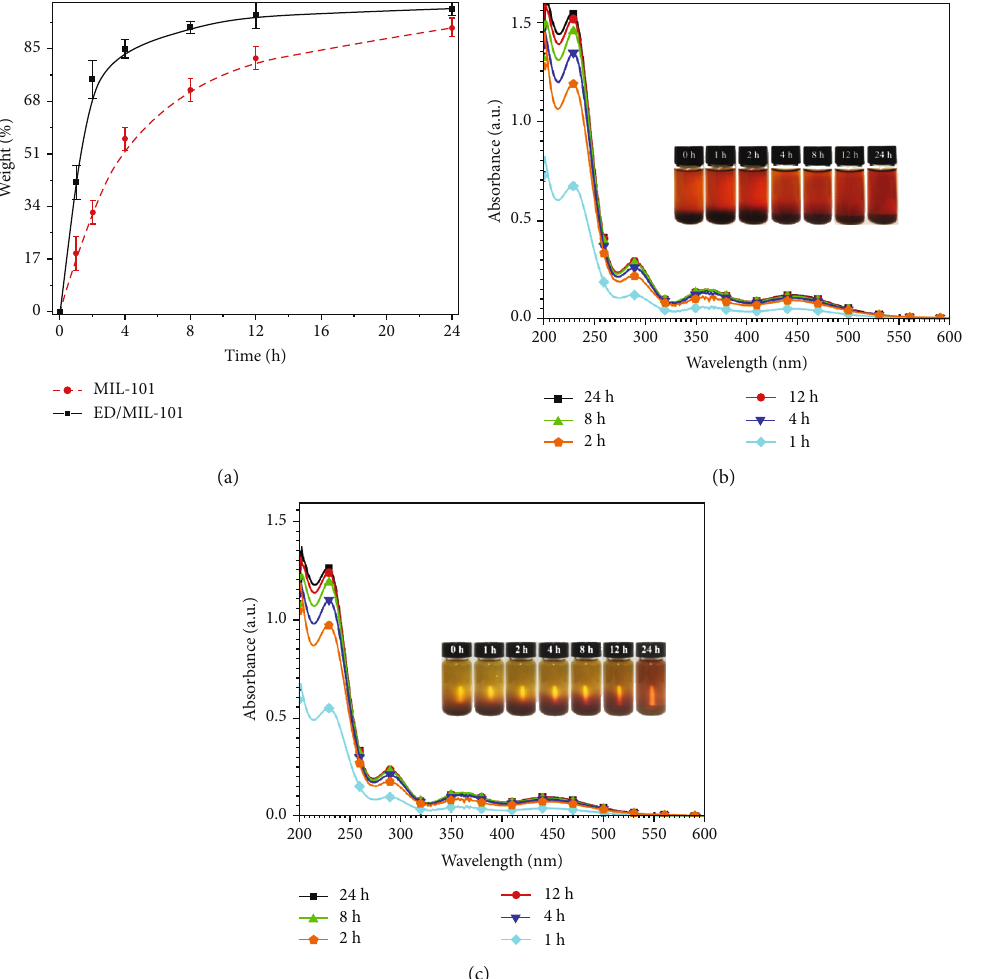
Figure 10: (a) The iodine release rate of etched MIL-101 and MIL-101 in ethanol. (b) The absorbance curve of solutions with di ff erent iodine release time for etched MIL-101. (c) The absorbance curve of solutions with di ff erent iodine release time for